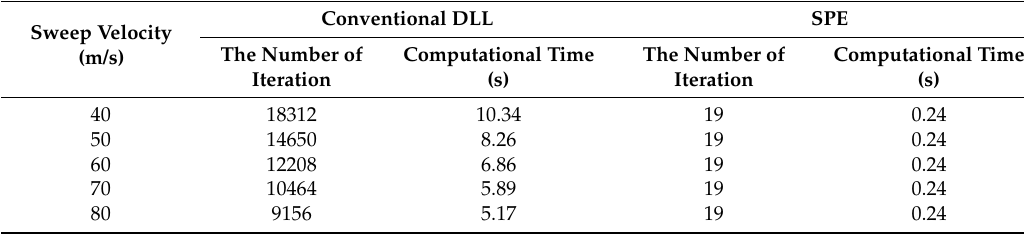
Table 7. Computational complexities of conventional DLL and